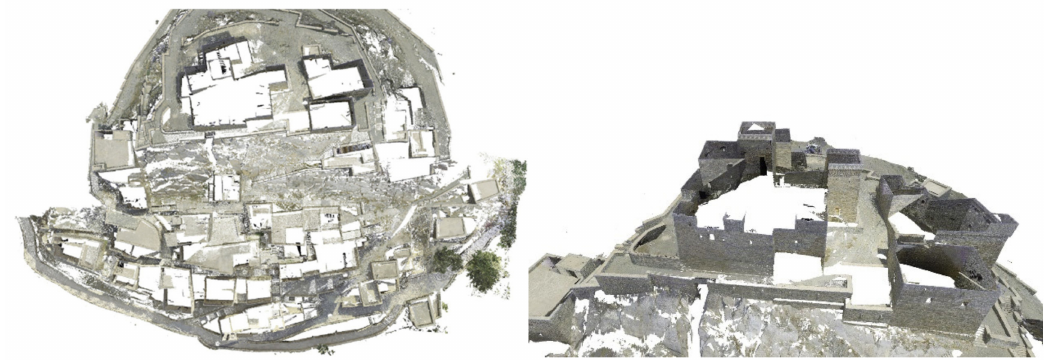
Figure 7. Unsampled roof and upper zone facades obscured from TLS.